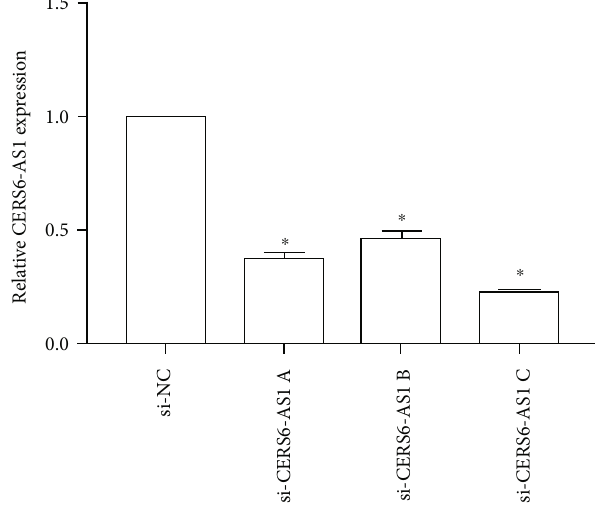
Figure 2: The expression level of CERS6-AS1 in NC and si-CERS6- AS1